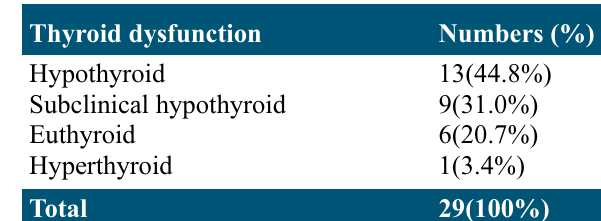
Table 5: Pattern of thyroid dysfunction among